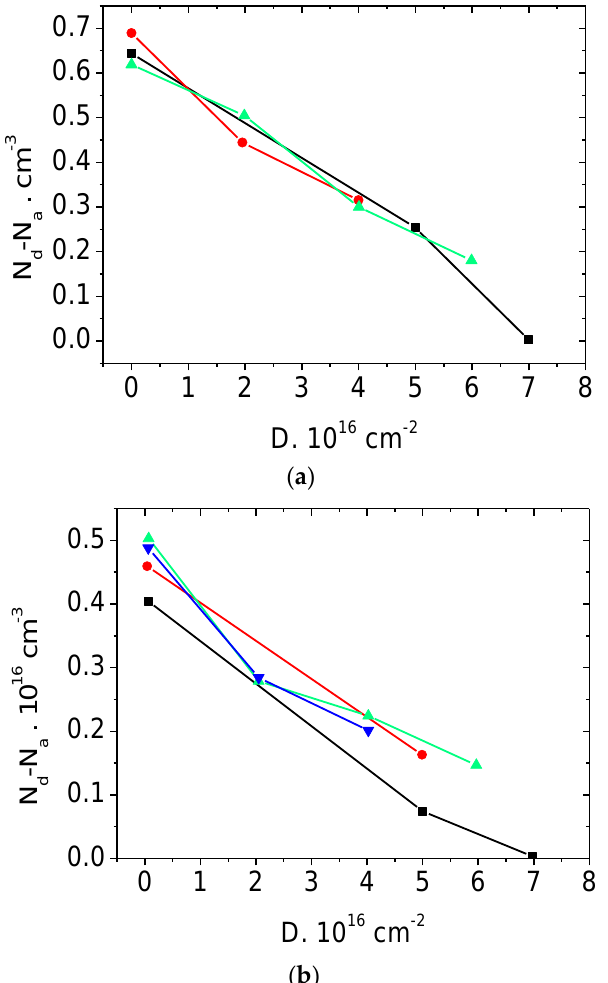
Figure 2. Dependence of the concentration N d – N a in Schottky diodes (CREE) with the blocking voltage of ( a ) 600 V and ( b ) 1200 V on the electron irradiation dose at room temperature. Different symbols correspond to different diodes from the same batch.